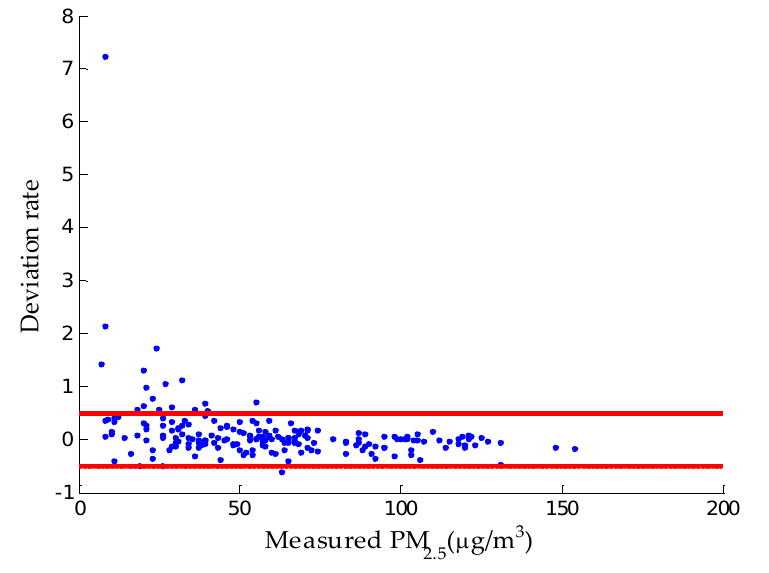
Figure 7. Deviation rate of predicted PM 2.5 .